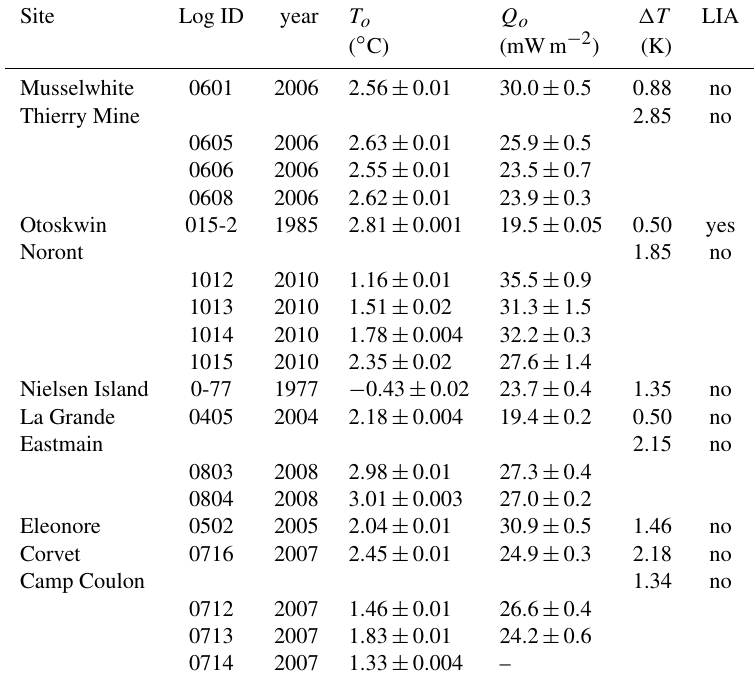
Table 3. Summary of GST history results, where T o is the reference surface temperature, Q o is the reference heat flux, and (cid:49)T is the difference between the maximal temperature and the reference temperature 500 years before